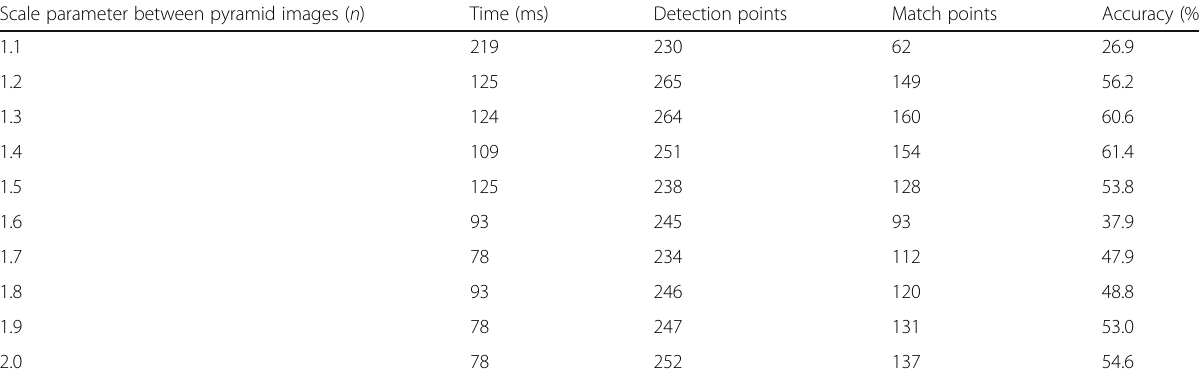
Table 7 Statistics table of the results of the constant change of the inter-image scale parameters when the pyramid layer is 8 Scale parameter between pyramid images ( n )